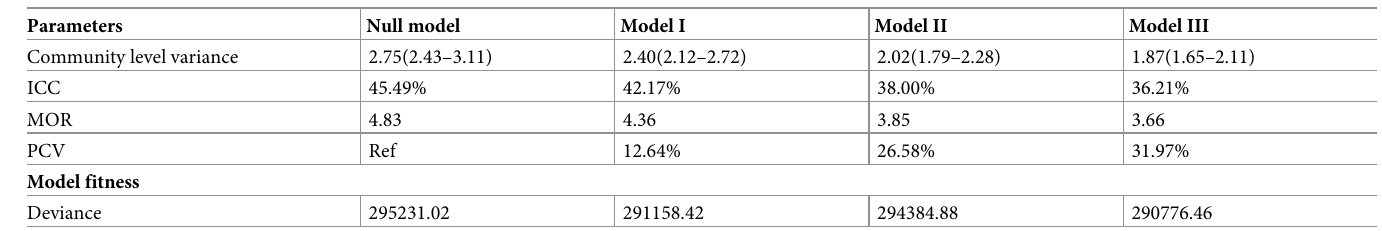
Table 3. Model comparison and random effect analysis